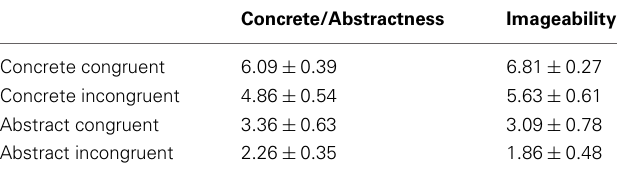
Table 1 | Mean rating scores on concreteness/abstractness and imageability of the critical